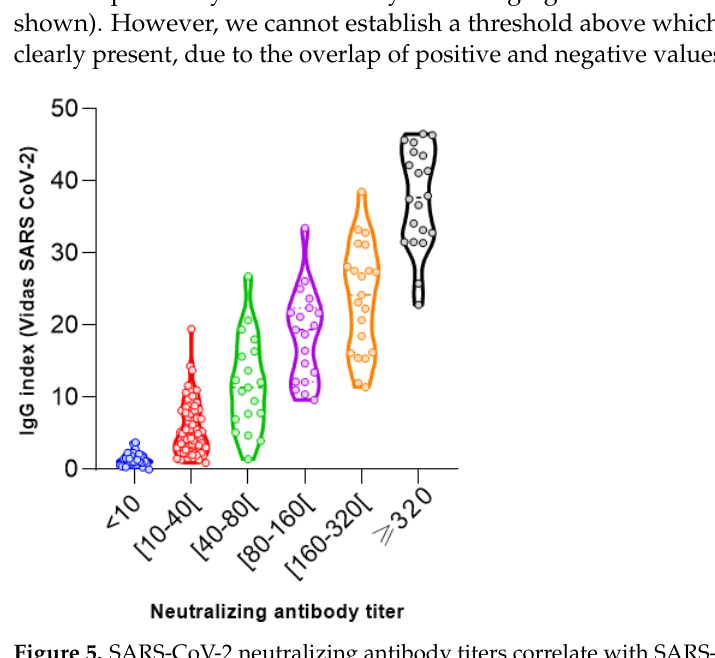
Figure 4. SARS-CoV-2 neutralizing antibody titers correlate with SARS-CoV-2 rapid lateral flow (AAZ ® ) (Spearman correlation coefficients ρ = 0.9341 and p -value < 0.0001).